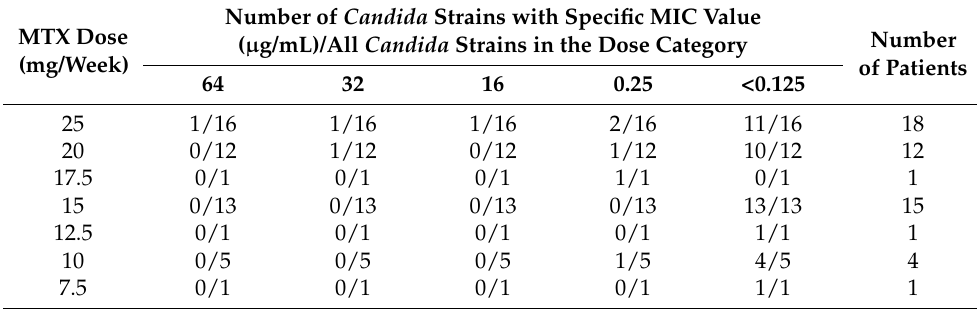
Table 5. Relationship between the MIC value for fluconazole among the cultured Candida strains of the studied group and the weekly dose of